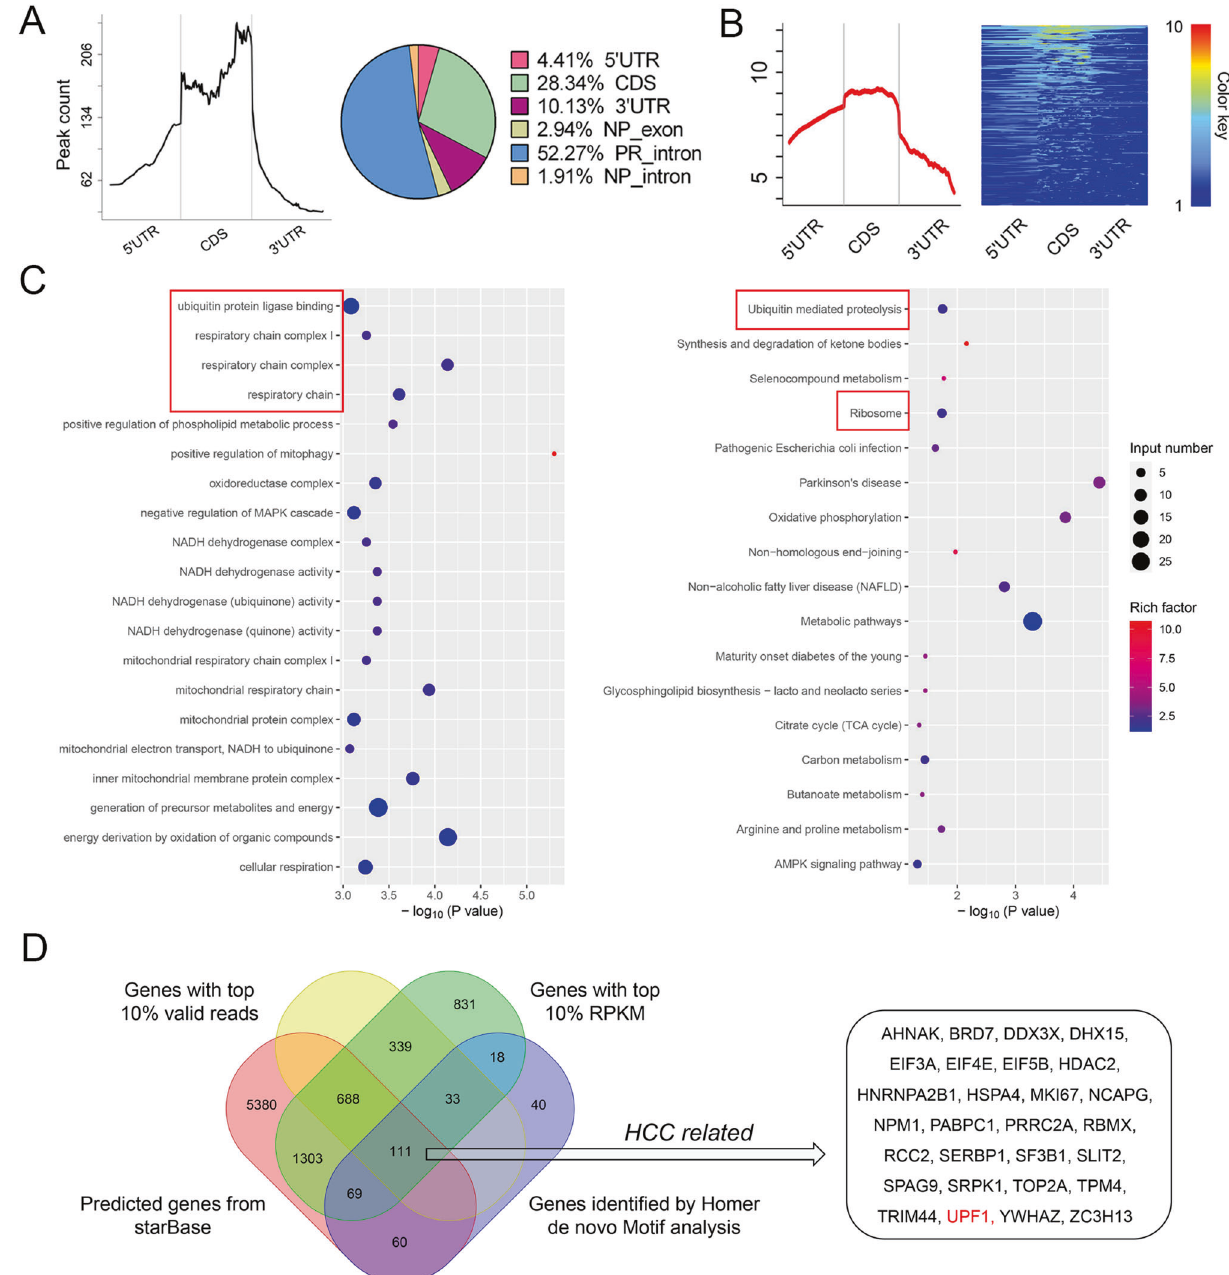
Fig. 3 Identi fi cation of the target gene of RBM47. A Peak distribution across the 5 ’ UTR, CDS, and 3 ’ UTR (left panel) as well as other functional segments (right panel). B Distribution of reads in peak regions. C GO (left) and KEGG (right) pathway analyses of genes predicted to bind to RBM47. The red box indicates pathways predicted to involve UPF1. D Venn diagram of target genes of RBM47 based on online prediction using starBase and